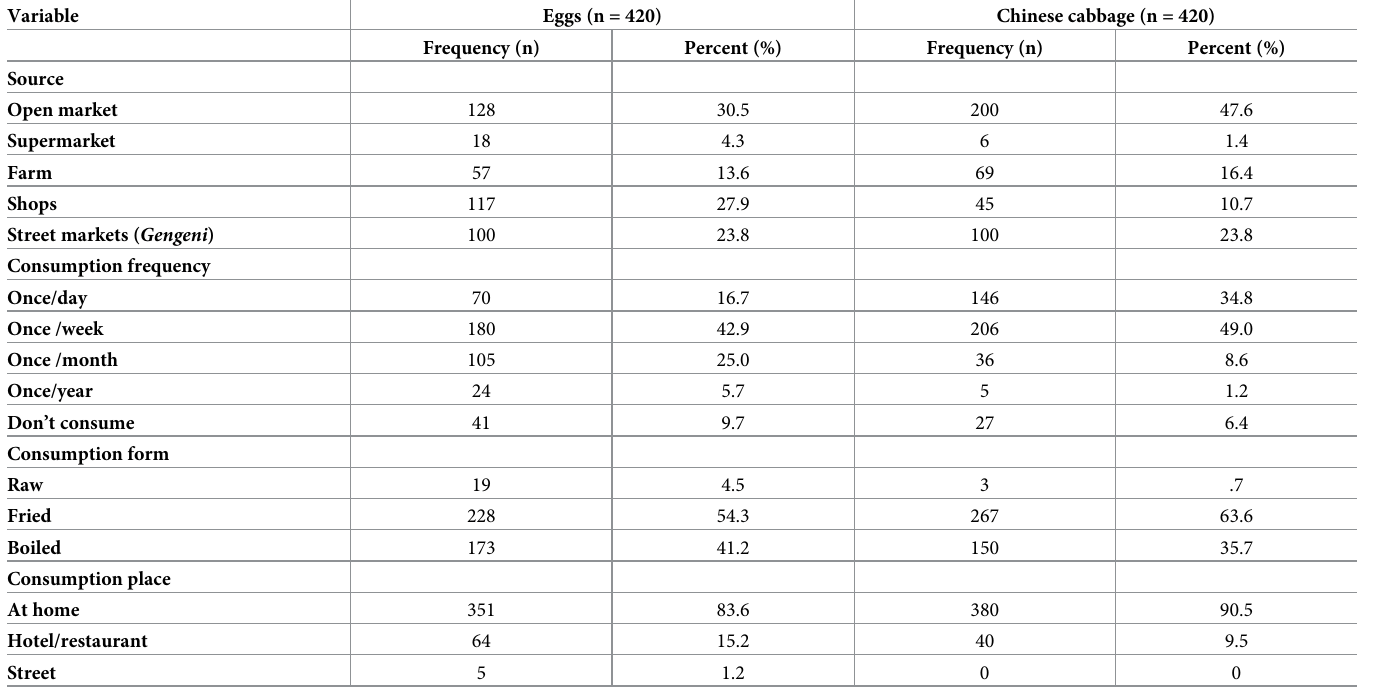
Table 2. Eggs and Chinese cabbage consumption